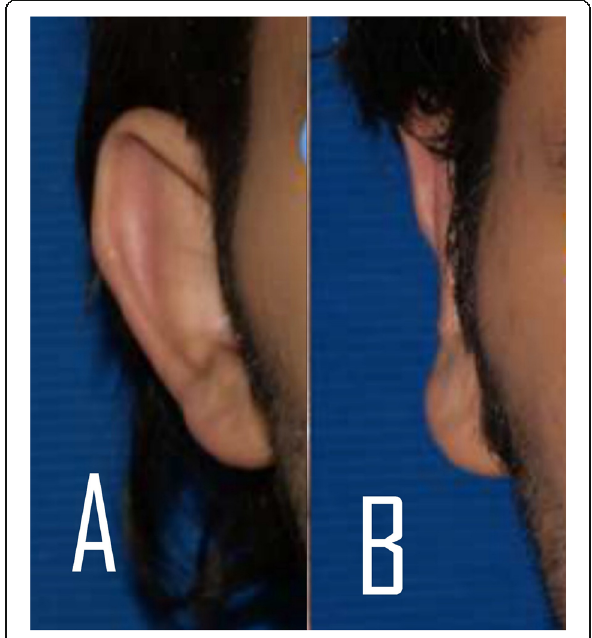
Fig. 7 Preoperative ( a ) and postoperative ( b ) shape of the right